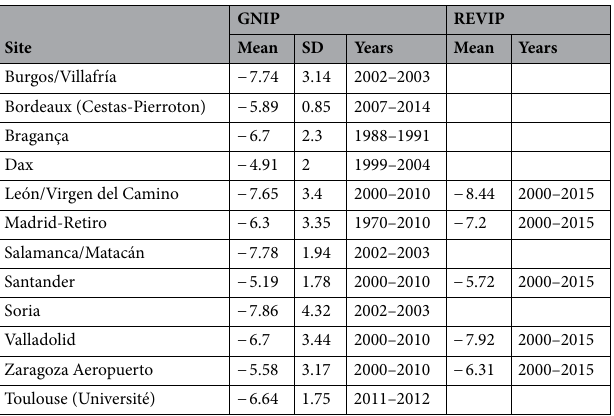
Table 4. δ 18 O average values of meteoric water from different stations in the north and northwestern of Iberian